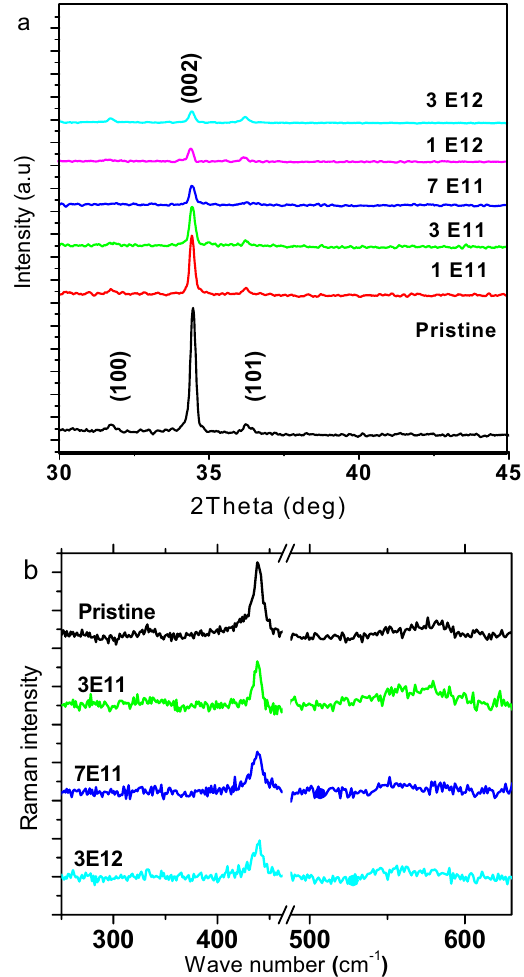
Figure 4. ( a ) X-ray diffraction spectra of the pristine and irradiated ZnO NR arrays at different fluences of 1E11, 3E11, 7E11, 1E12, 3E12 ions cm − 2 with 150MeV Ag ions ( b ) Raman spectra of pristine and irradiated ZnO NR arrays, irradiated at the fluences of 3E11, 7E11 and